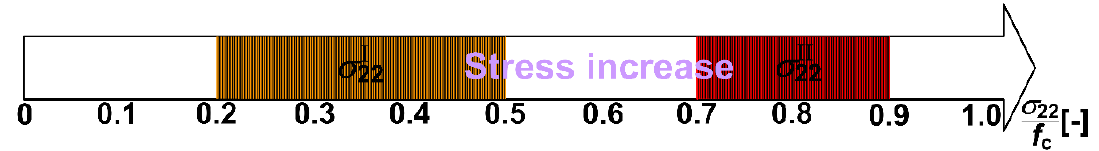
Figure 2. Ranges of the levels of critical stress 𝜎 (cid:2870)(cid:2870)(cid:3010) and 𝜎 (cid:2870)(cid:2870)(cid:3010)(cid:3010) in ordinary concrete subjected to various material, technological, and service factors (according to [95]).